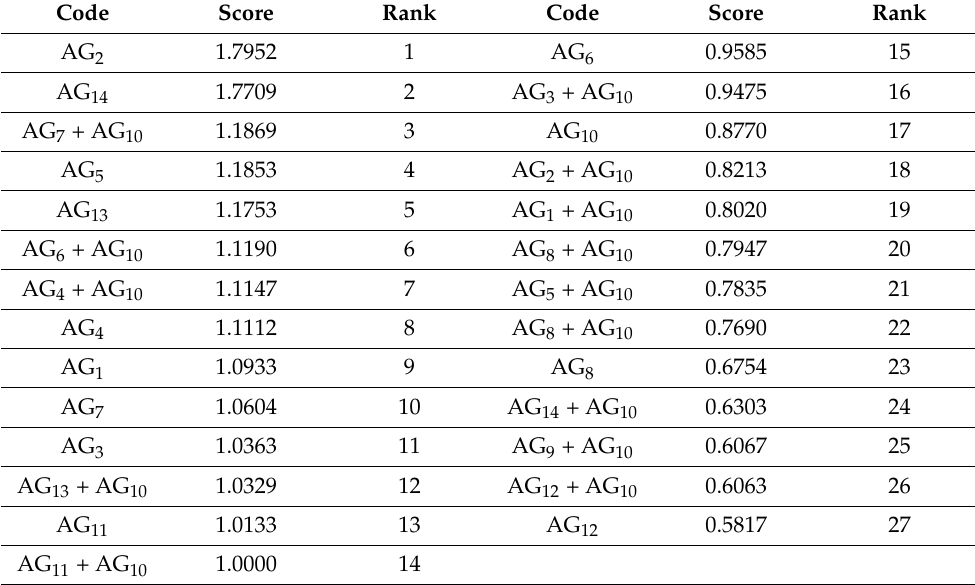
Table 16. Performance ranking of